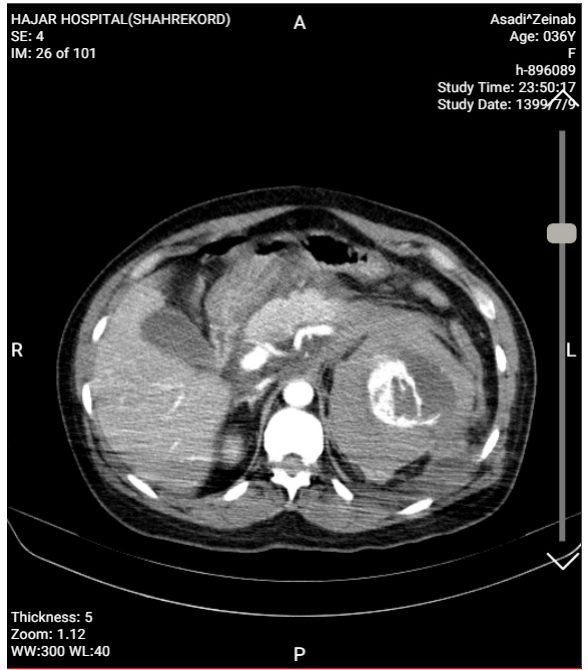
Figure 2. CT scan showing hemorrhagic renal cysts in the left kidney. Note . CT: Computerized tomography